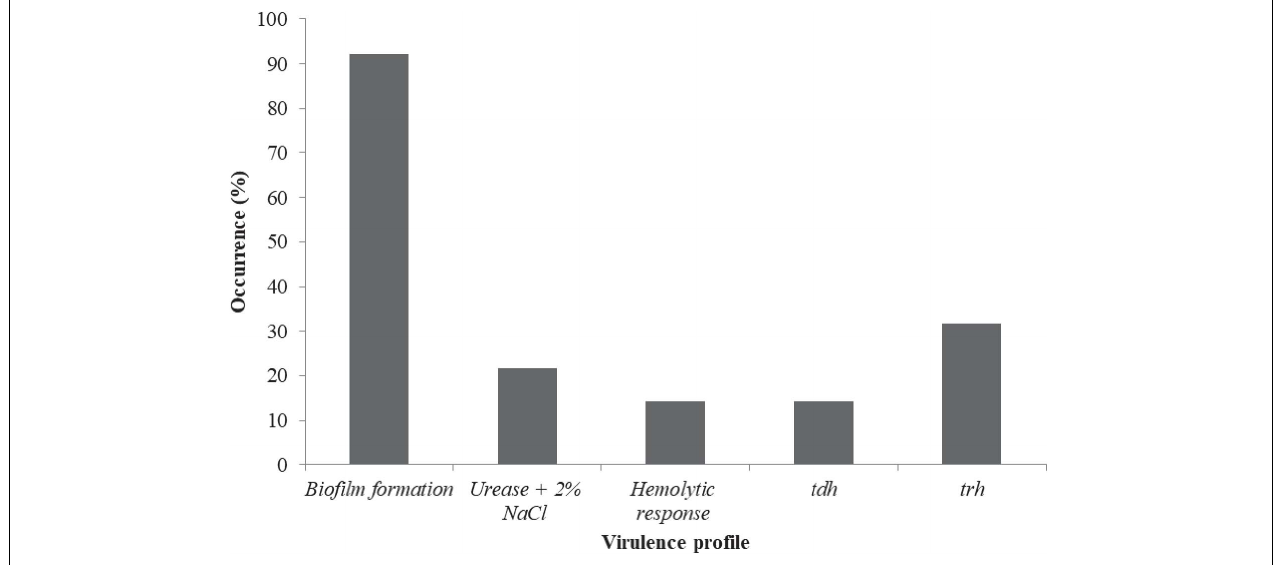
FIGURE 2 | Phenotypic and genotypic virulence profile of V. parahaemolyticus from African salads. Thermostable direct hemolysin ( tdh ) and TDH-related hemolysin ( trh ).